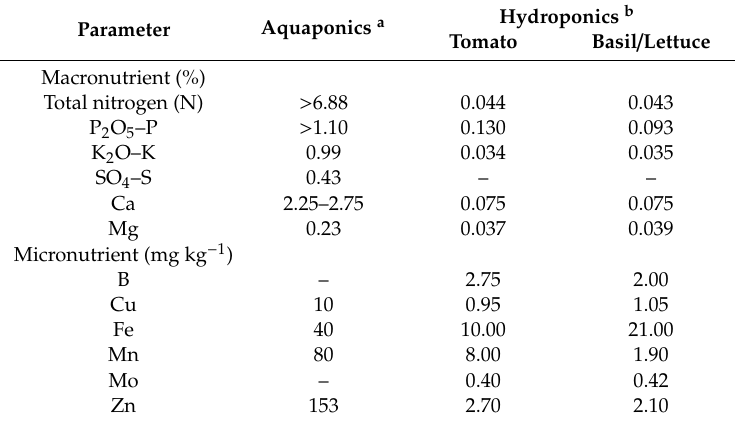
Table 2. Macro- and micronutrient compositions and concentrations used in aquaponic and hydroponic